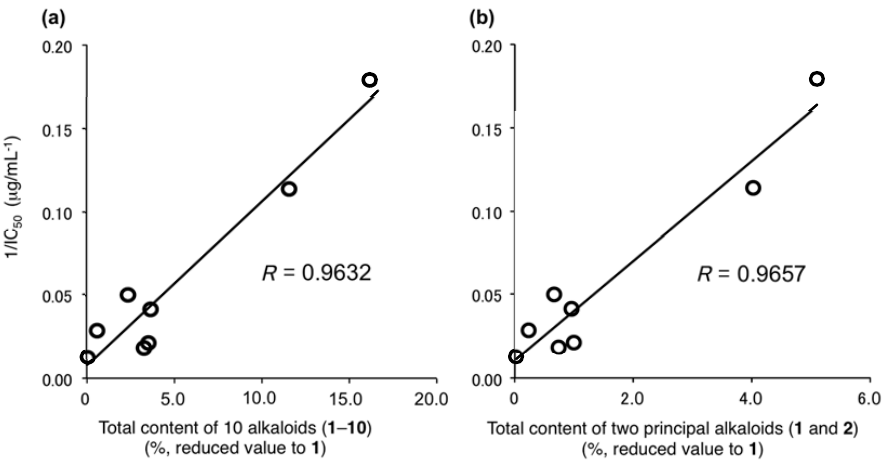
Figure 5. Correlations between the melanogenesis inhibitory activities and total content. ( a ) Total content (%) of 10 alkaloids ( 1 – 10 ); ( b ) Total content (%) of two principal alkaloids ( 1 and 2 ). Total contents (%) of the alkaloids are presented in values reduced to the content of nuciferine ( 1 ), calculated based on the ratio of IC 50 values ( μ g/mL) against melanogenesis inhibitory activities. Table 10. Inhibitory effects of the methanol extract from lotus flower (NN-1–NN-8) on theophylline-stimulated melanogenesis and viability in B16 4A5